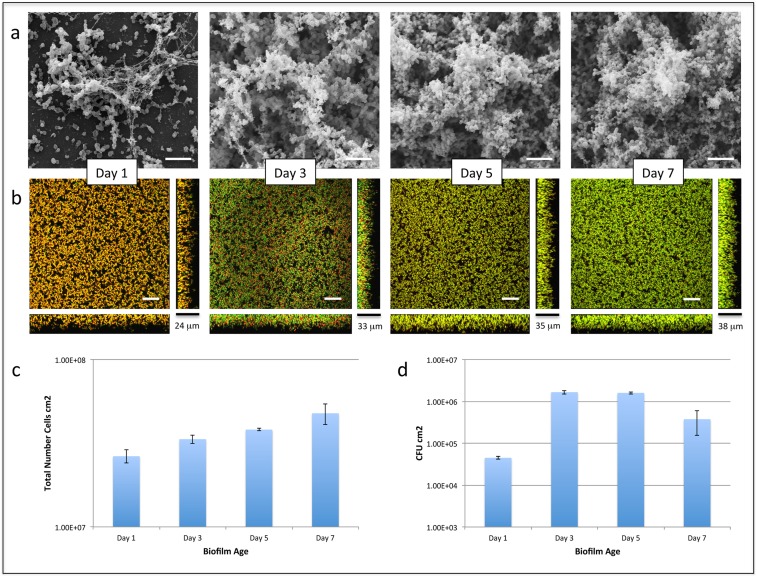

S. pneumoniae serotype 14 day 1, 3, 5 and 7 biofilms imaged using (a) scanning electron microscopy with Alcian Blue staining (8,000x magnification; scale bar: 5 µm), and (b) confocal microscopy using Live/Dead staining, with sideviews (YZ – right) and (XZ – bottom) sagittal sections of the biofilm.Scale bar beside YZ sagittal sections represents average biofilm thickness. Scale bar in xy pane: 30 µm. (c) Bar chart comparing the total number of cells between day 1, 3, 5 and 7 biofilms. (d) Bar chart comparing number of viable cells between day 1, 3, 5 and 7 biofilms through CFU cm−2 measurement.